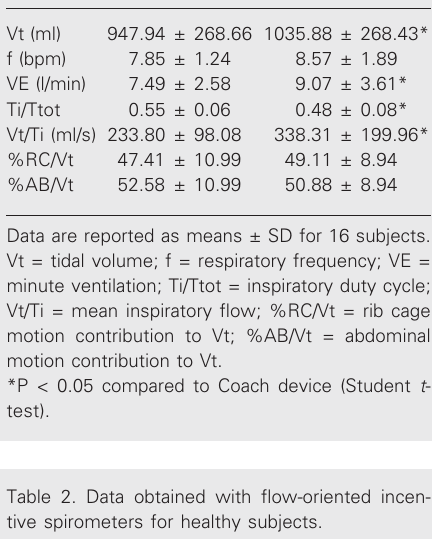
Table 1. Data obtained with volume-oriented in- centive spirometers for healthy subjects. Respiratory Coach Voldyne